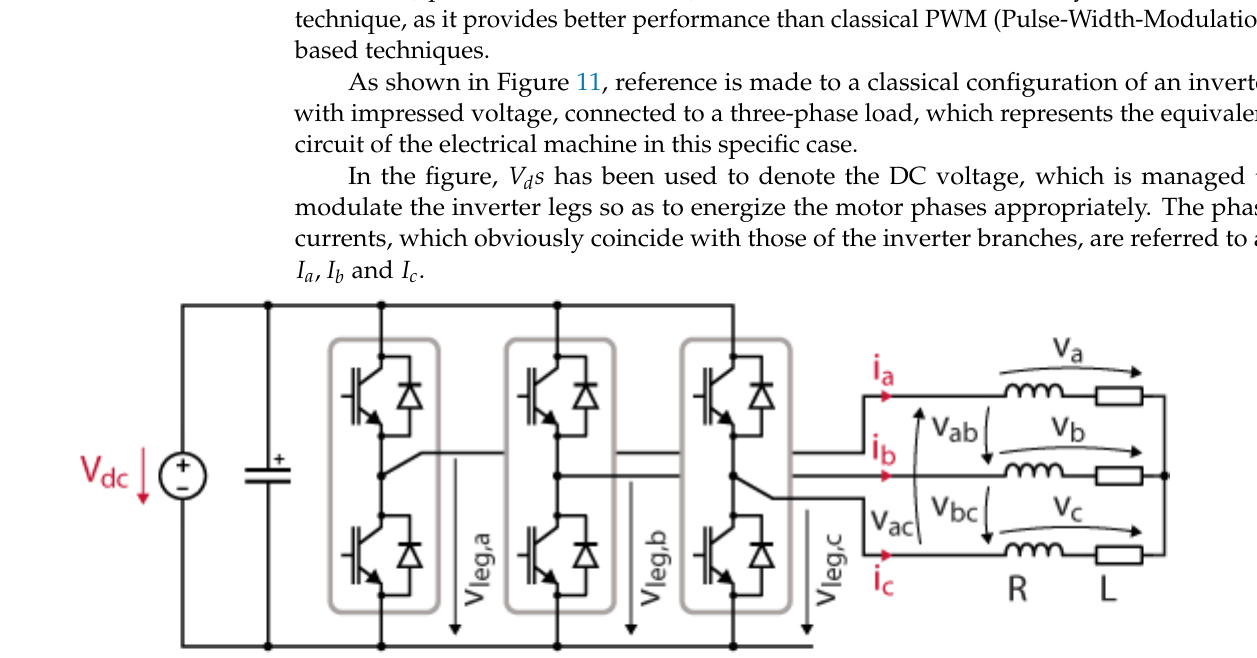
Figure 11. Topology of a two-level inverter with 3-phase